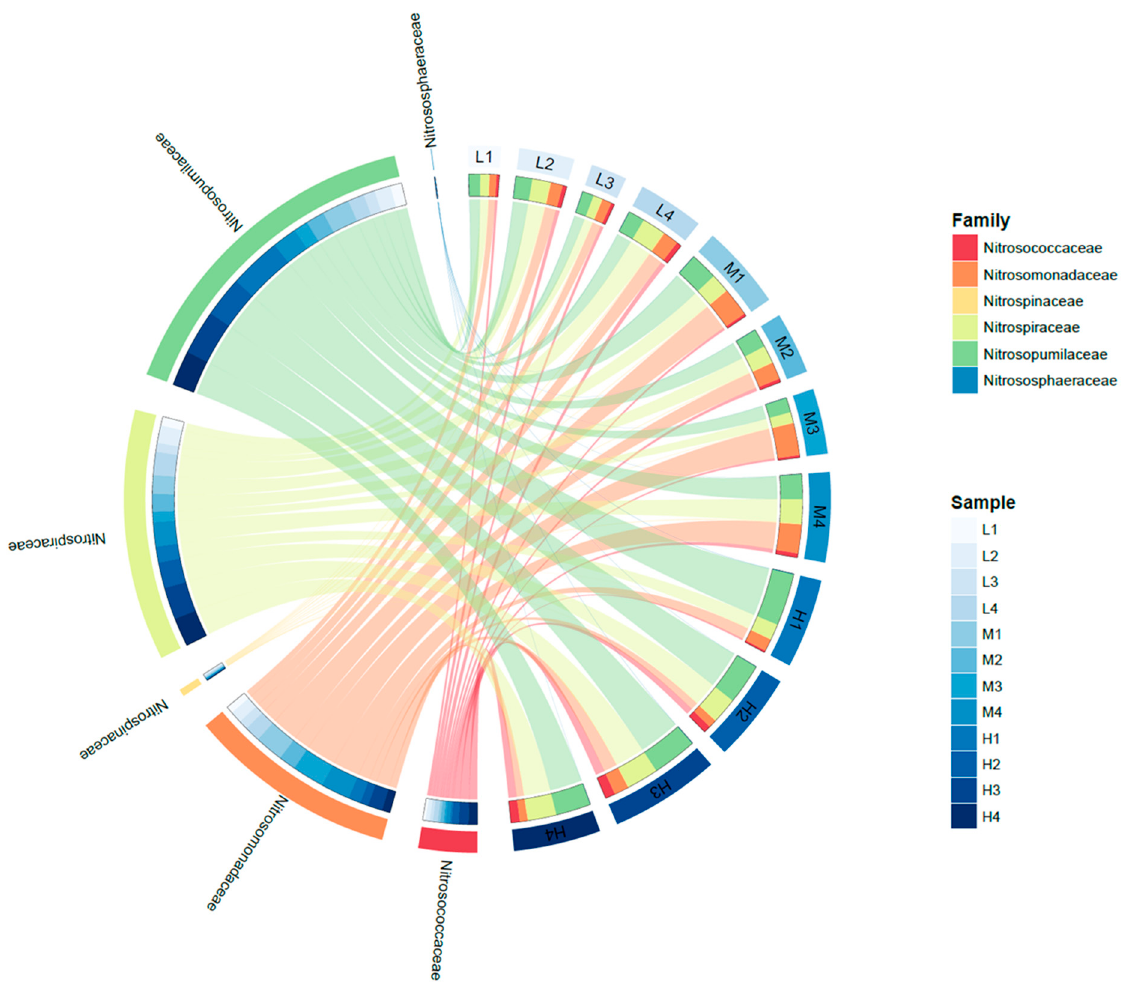
Figure 6. Circus plot of abundances of nitrifying microorganisms in all 12 samples. Abundances were represented by reading numbers of each family via 16S v4 amplicon sequencing. (AOB: Nitrosococcaceae, Nitrosomonadaceae ; NOB: Nitrospinaceae, Nitrospiraceae ; AOA: Nitrosopumilaceae, Nitrososphaeraceae ).